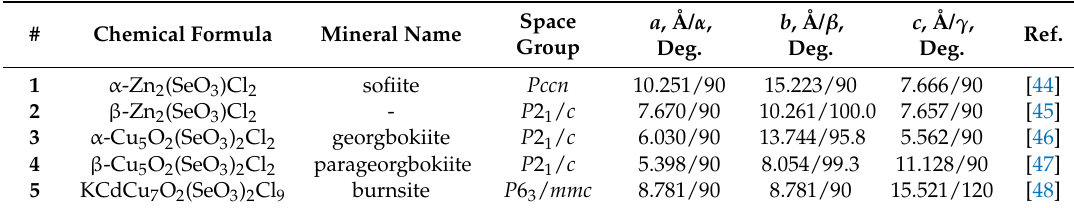
Table 1. Crystallographic data for selected selenite chlorides analyzed using the atoms-in-molecules (AIM)